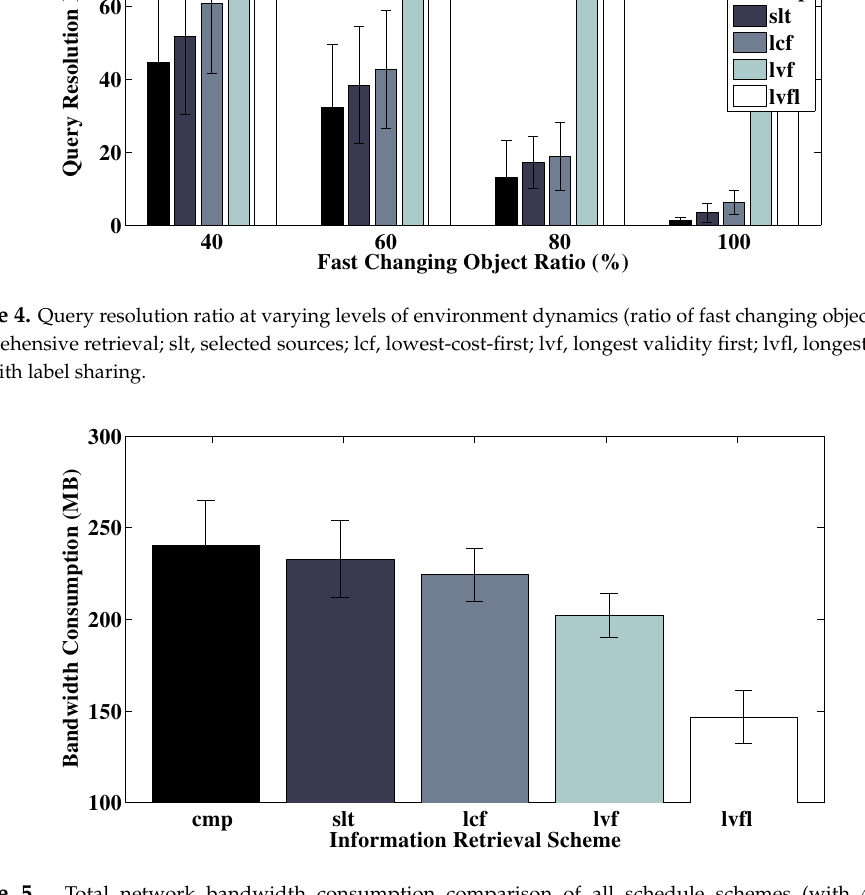
Figure 5. Total network bandwidth consumption comparison of all schedule schemes (with 40% fast changing